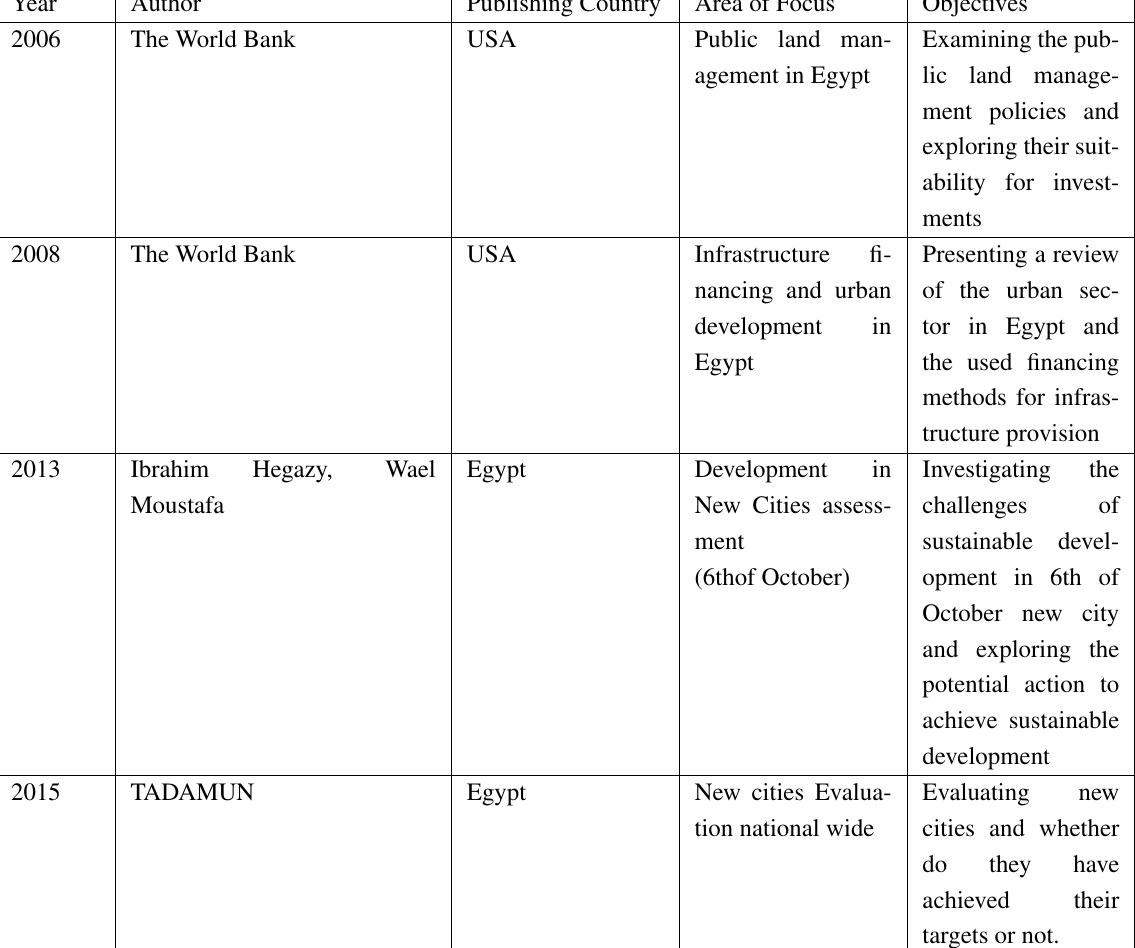
Table 1. Literature Review Summary of Papers Concerned with the Negative Impacts of LBF in